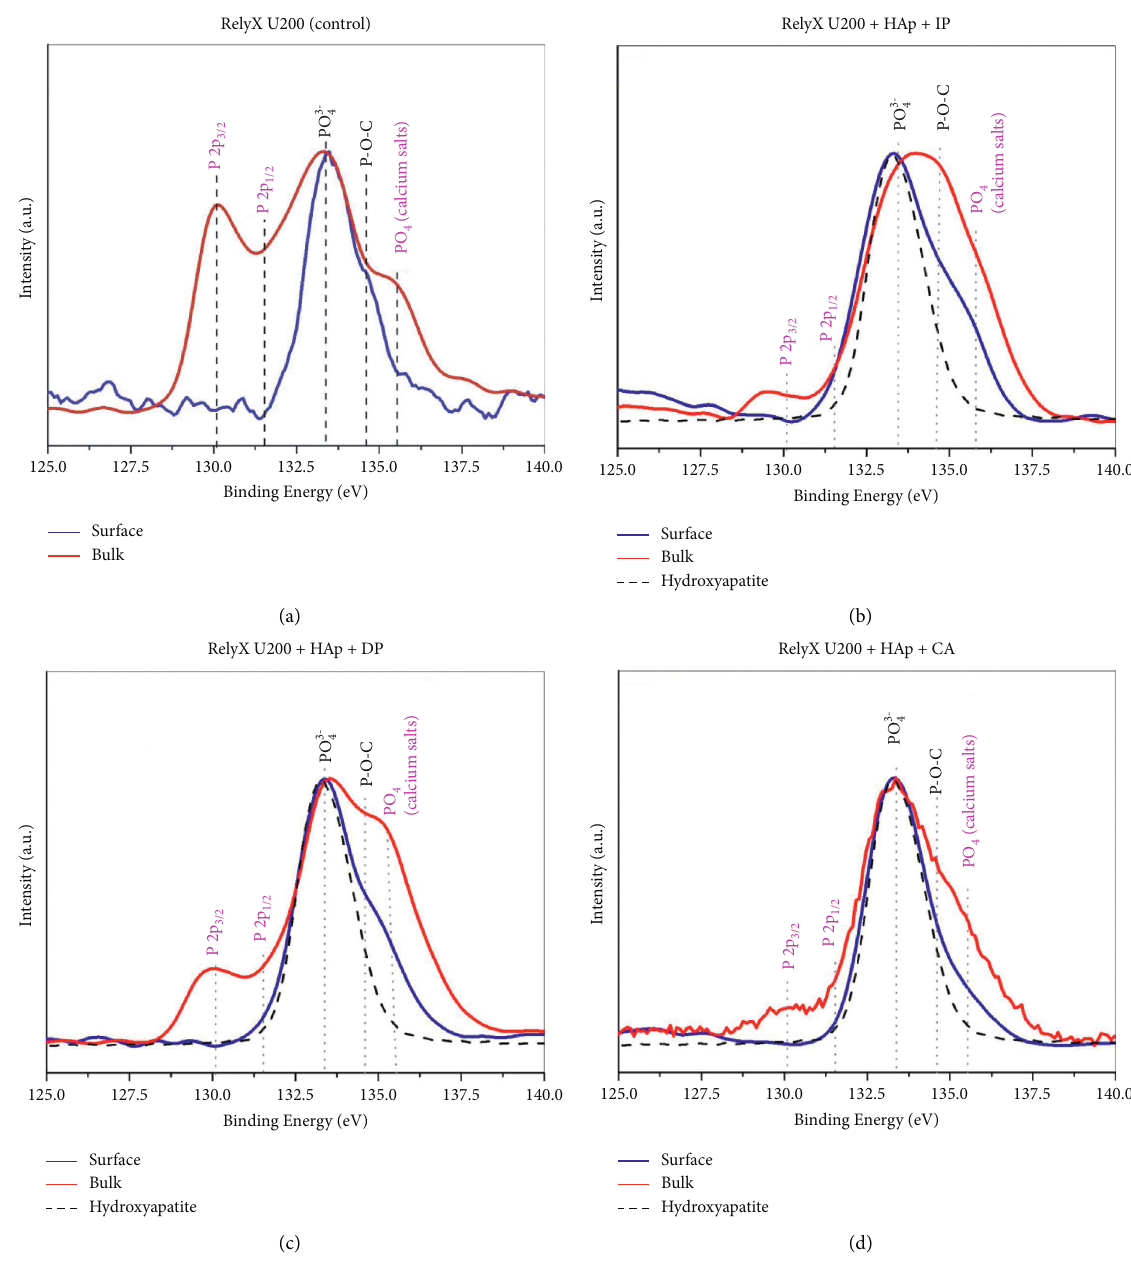
Figure 3: High-resolution P2p spectra of (a) RelyX U200 (control), (b) RelyX U200+HAp +IP, (c) RelyX U200+HAp +DP, and (d) RelyX U200+HAp +CA. The blue lines show the spectra obtained from the surface, while the red spectra were obtained from the bulk. The dashed lines show the spectrum of HAp, which was inserted for comparison purposes. The chemical species assigned to magenta are those that appeared in the spectra, mostly in